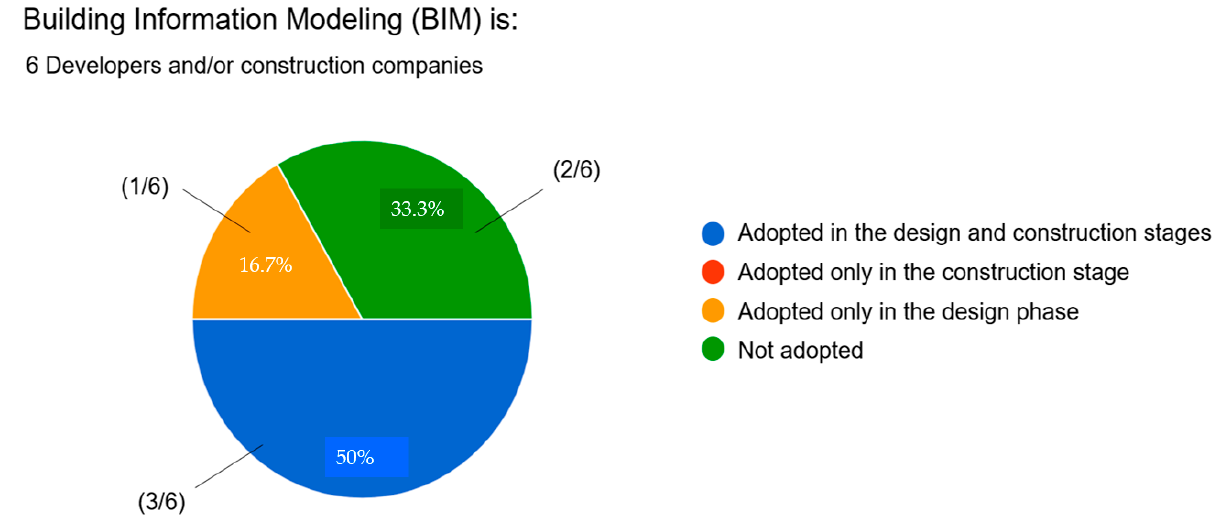
Figure 4. Stages in which BIM is adopted by developers and/or construction companies.